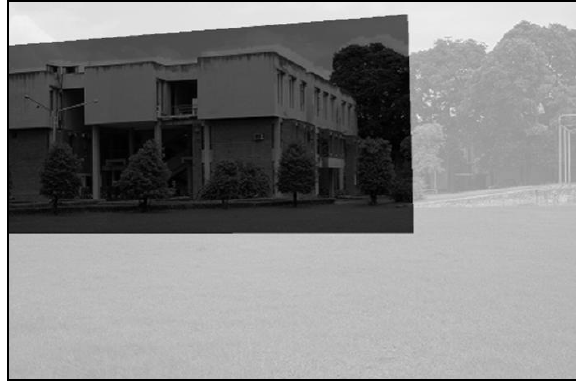
Figure 6. Registration of LiDAR intensity image (foreground) and camera image (background)